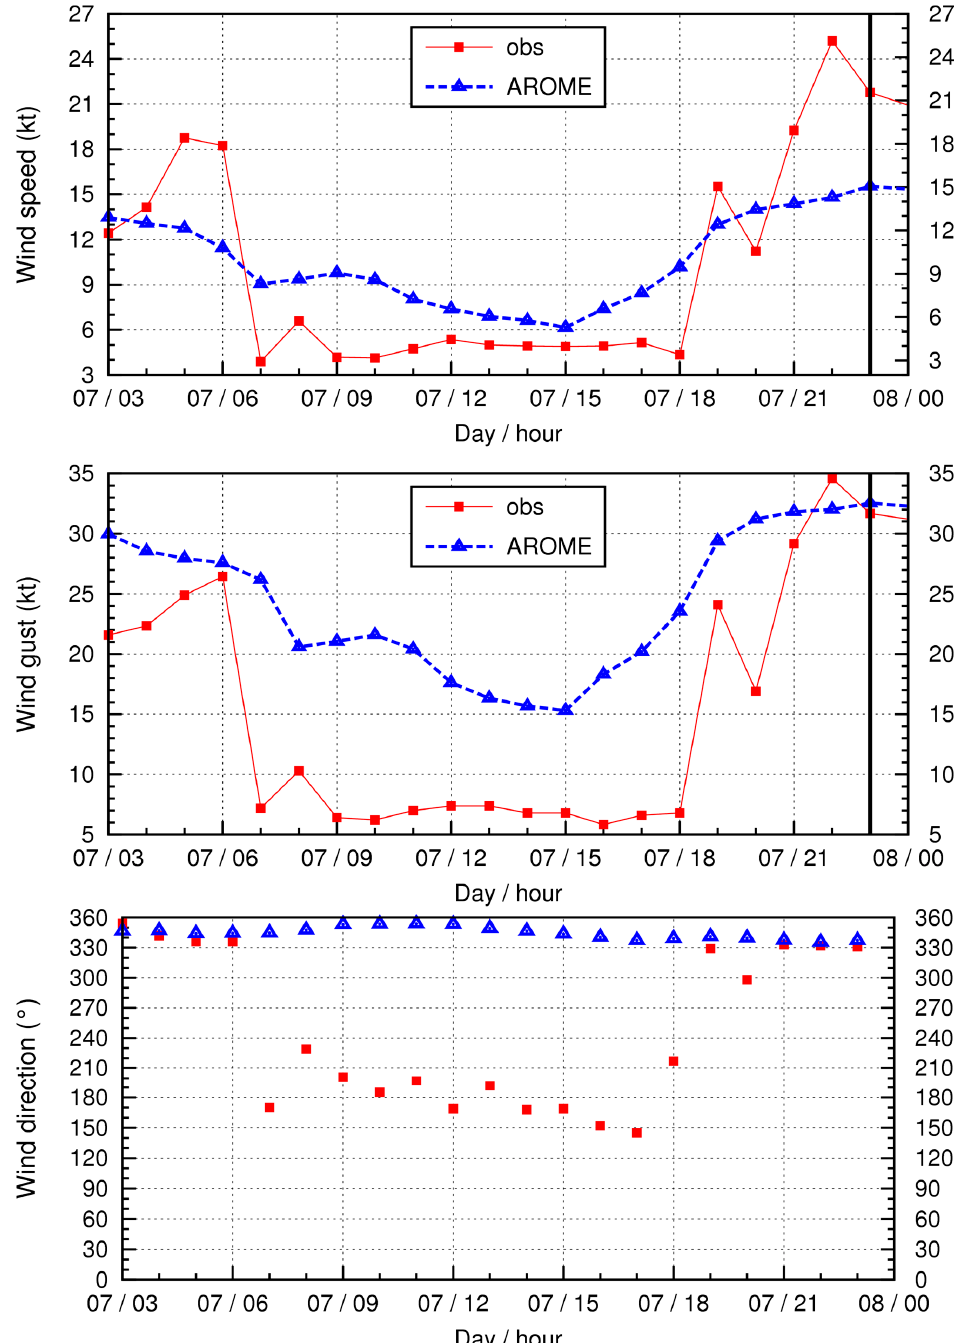
Figure 11 . Time evolution of wind speed, wind gust and wind direction at 10-m height, from AROME forecast and observations at RWY05, on 7 August 2016. The time of a missed approach is marked as an impulse.